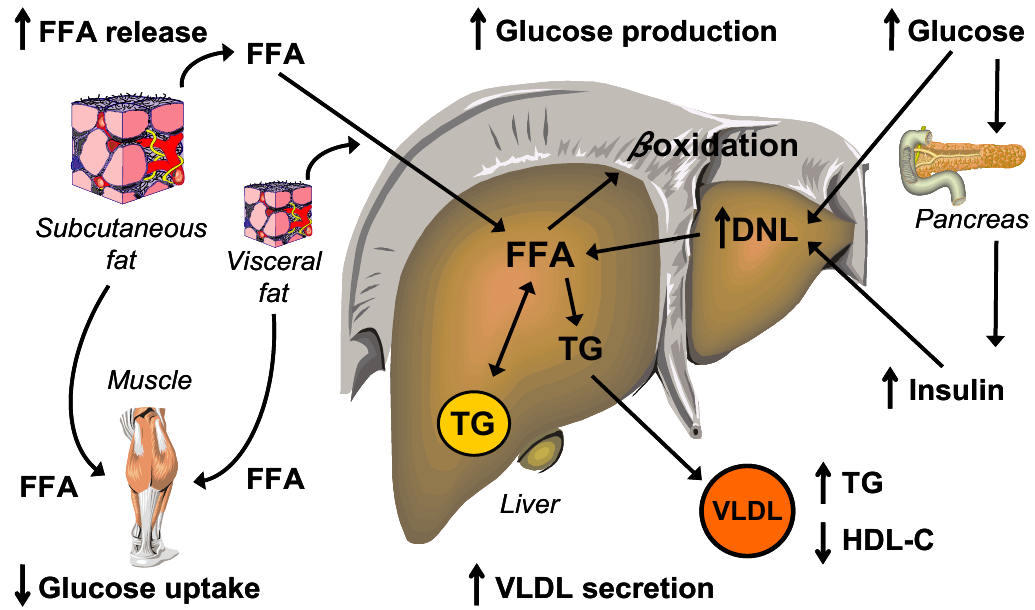
Figure 2. Mechanisms of metabolic dysfunction in NAFLD. Nonalcoholic fatty liver disease (NAFLD) is associated with increased release of free fatty acids (FFA) from adipose tissue, because of enlarged fat stores and the inability of insulin to down-regulate lipolysis ( i.e. , adipose tissue insulin resistance); systemic plasma FFA are subsequently taken up by the liver at increased rates. Intrahepatic fatty acid availability is further augmented by increased hepatic de novo lipogenesis (DNL). Increased availability of fatty acids in the liver results in accumulation of intrahepatic triglyceride (TG) and steatosis, oversecretion of very low density lipoprotein (VLDL) TG and various form of dyslipidemia, and increased glucose production ( i.e. , hepatic insulin resistance).